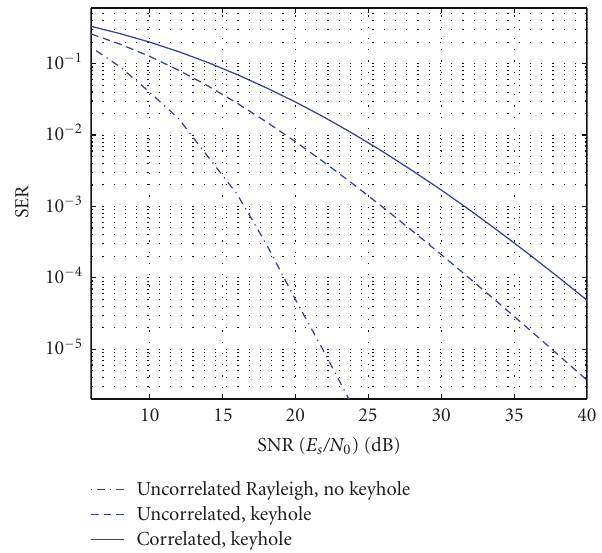
Figure 4: Performance degradation and loss of diversity due to the keyhole e ff ect and antenna correlation in a 2 × 2 MIMO system based on G 2 (Alamouti code) [19], 8-PSK modulation, and the exponential antenna correlation